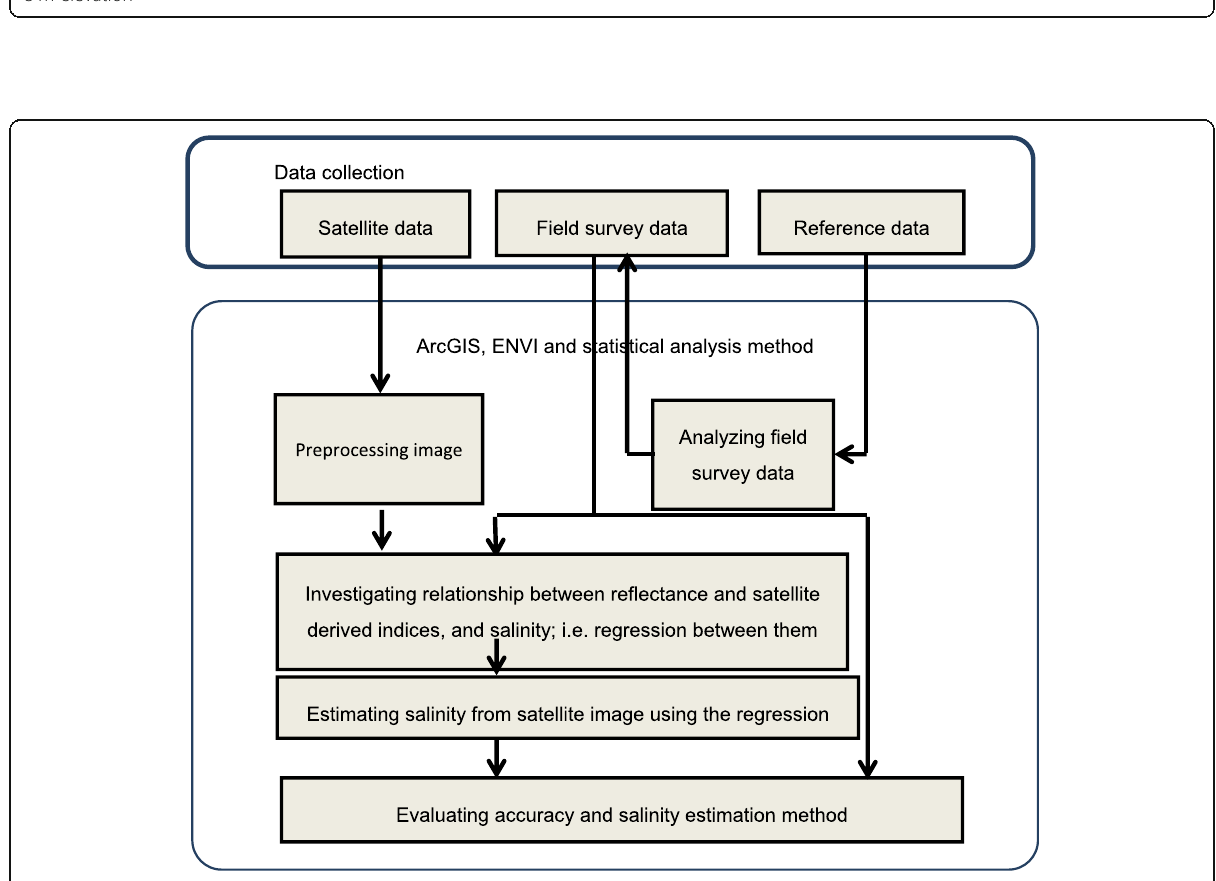
Fig. 5 The workflow of salinity retrieval using Landsat 8 OLI